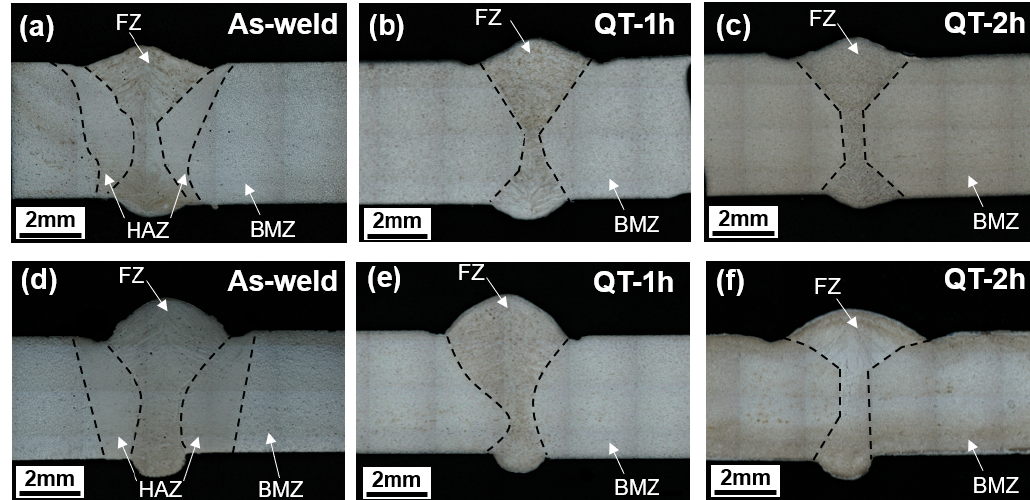
Figure 5. Macrostructures of the laser-arc hybrid weld joints: ( a – c ) Type-I and ( d – f ) Type-II, (FZ: fusion zone, HAZ: heat affected zone, BMZ: base material zone).